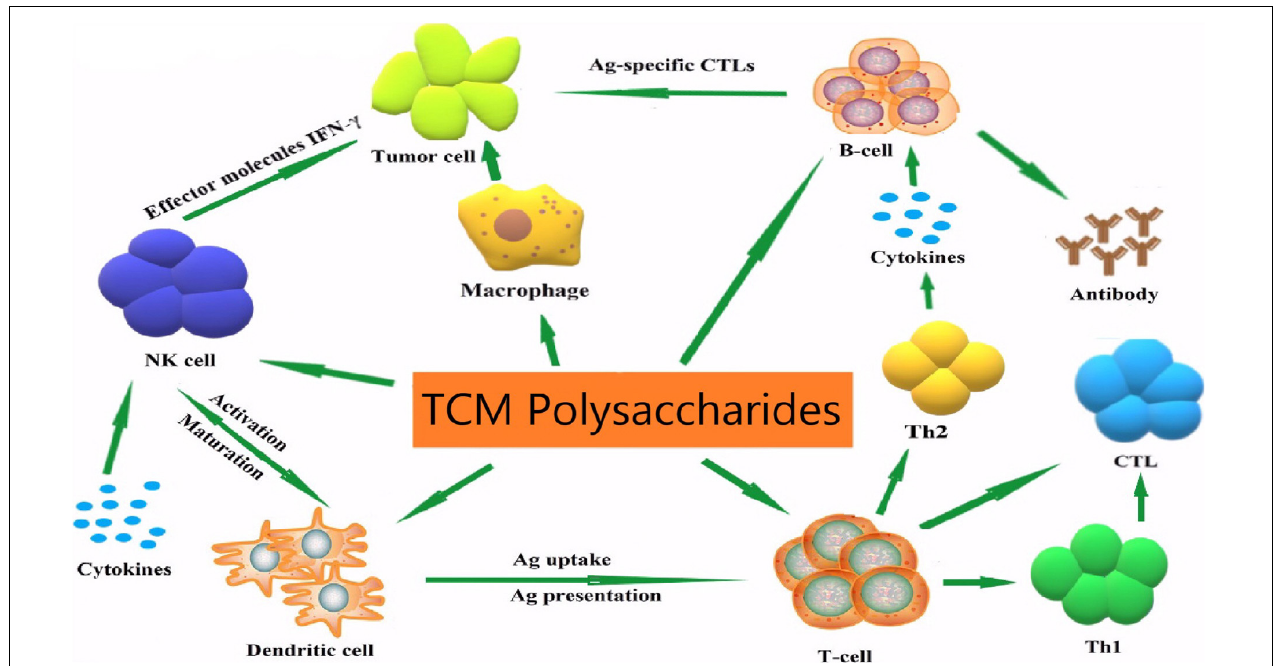
FIGURE 2 | Immune regulatory mechanisms of TCM